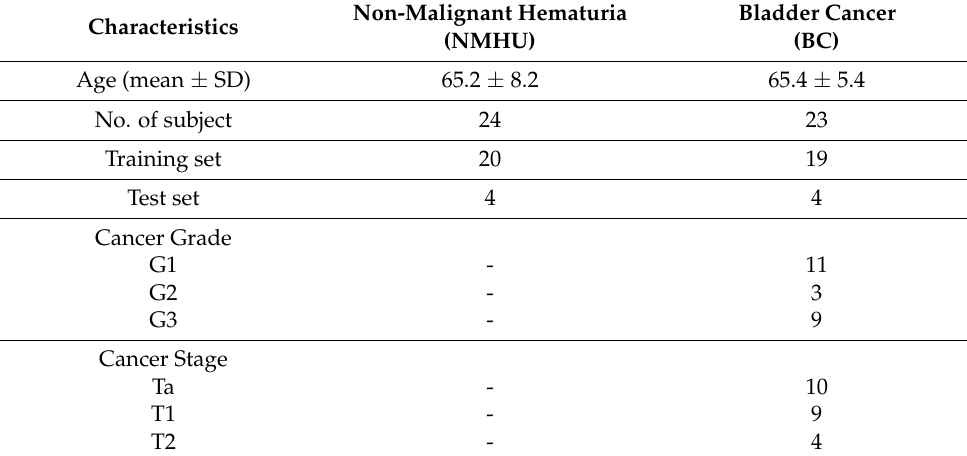
Table 1. Clinicopathological characterization of